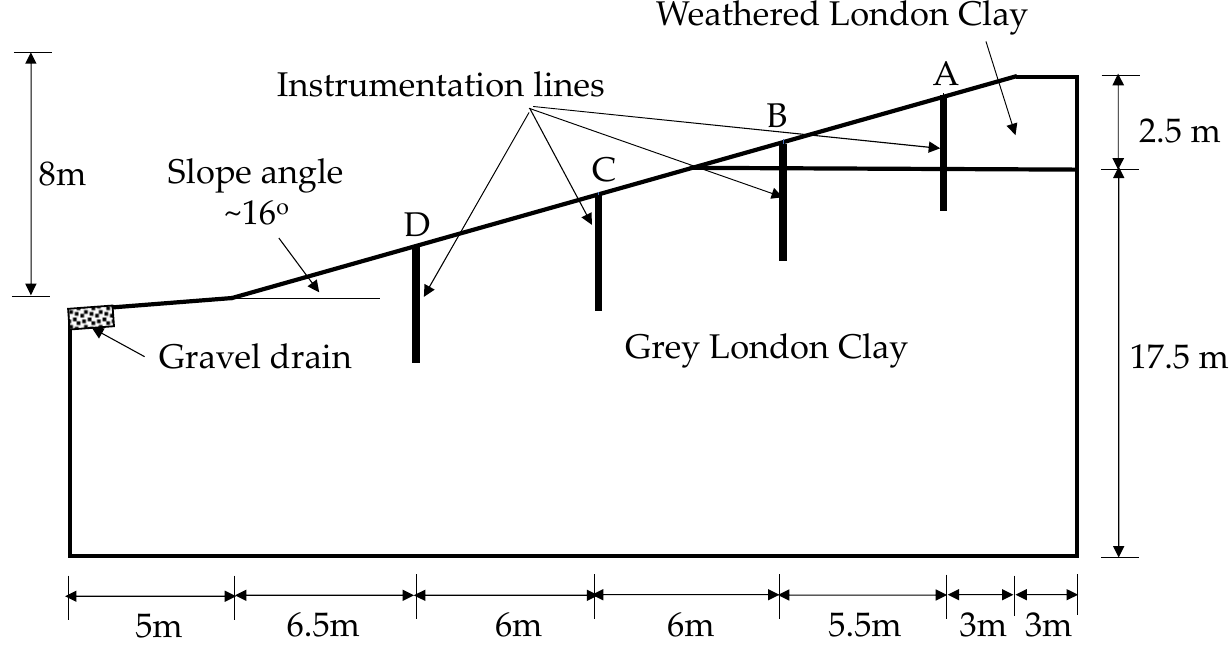
Figure 2. A cross-section of the Newbury cutting (dimensions after Smethurst et al. [20]).